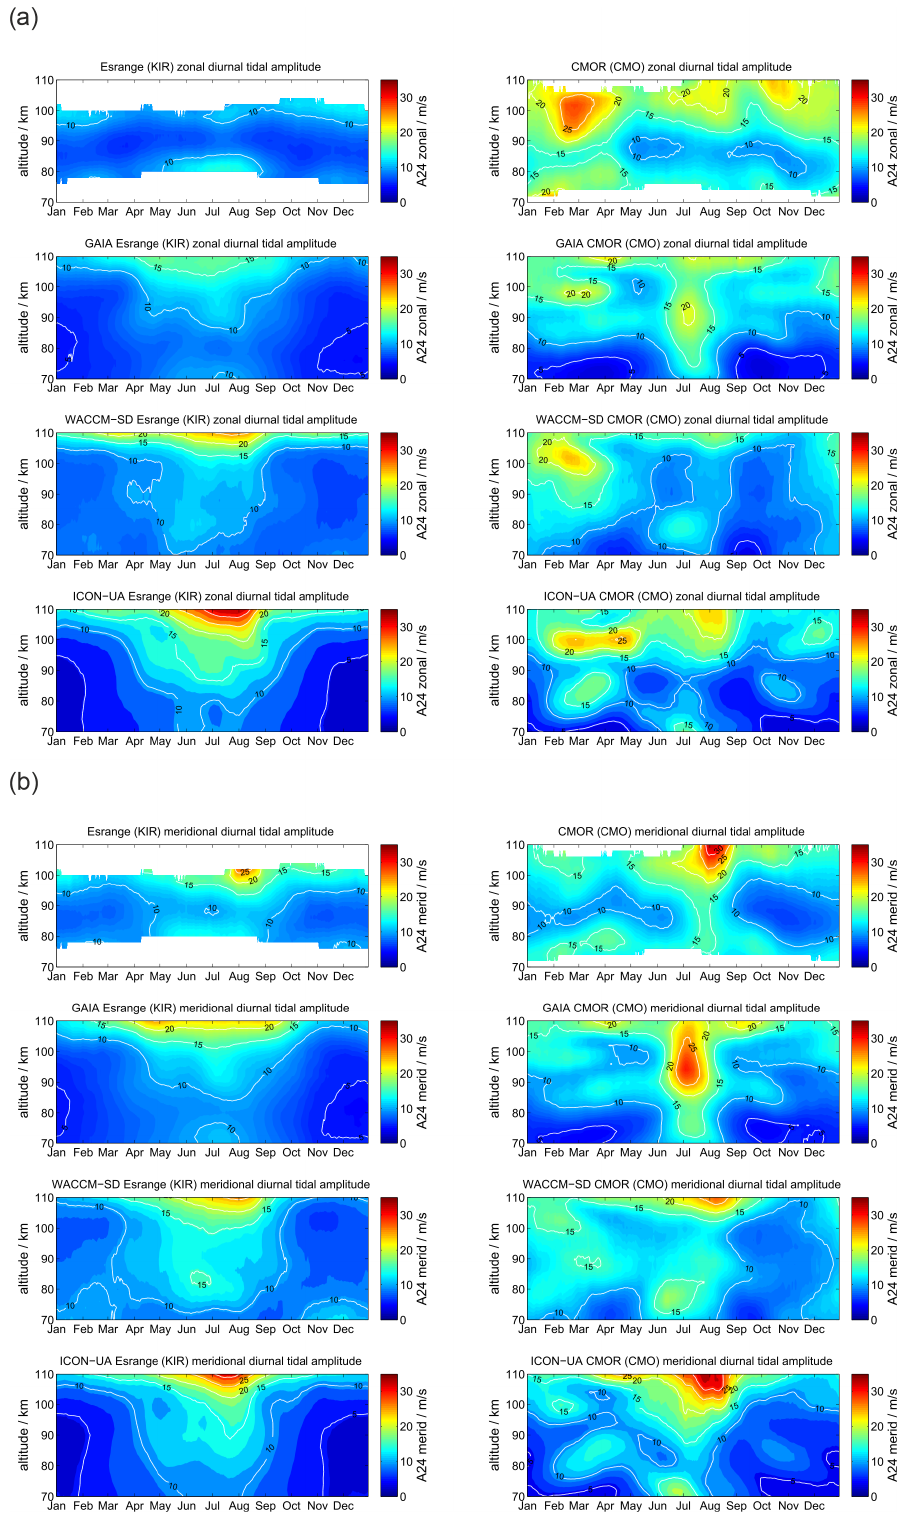
Figure A2. The same as Fig. 2, but for the diurnal tidal amplitudes above KIR and CMO.